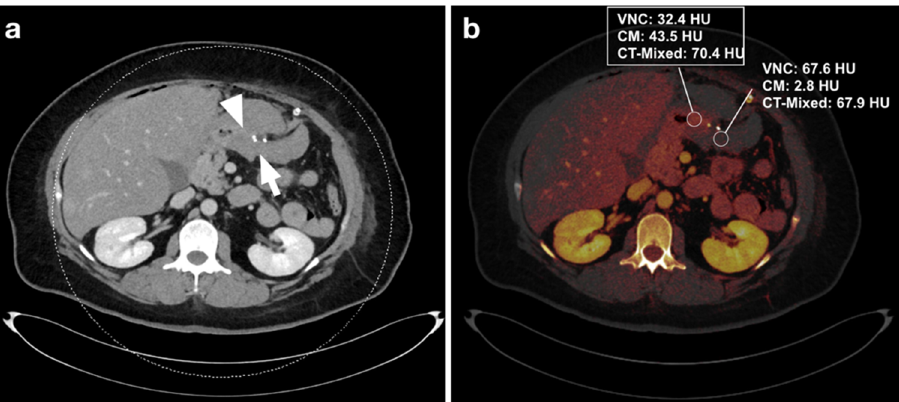
Figure 3. ( a ) 46-year-old male patient with intra-abdominal hematoma (arrow) adjacent to small bowel loops (arrowhead) after gastric tube surgery. ( b ) Measurement of iodine maps shows a difference in VNC and iodine values (dual-energy CT) between hematoma and intestinal loops, but no difference in DE-LB (single-energy CT). This case was incorrectly rated as negative in the DE-LB procedure by all 3 readers. After CT, the patient underwent laparoscopy with hematoma evacuation.